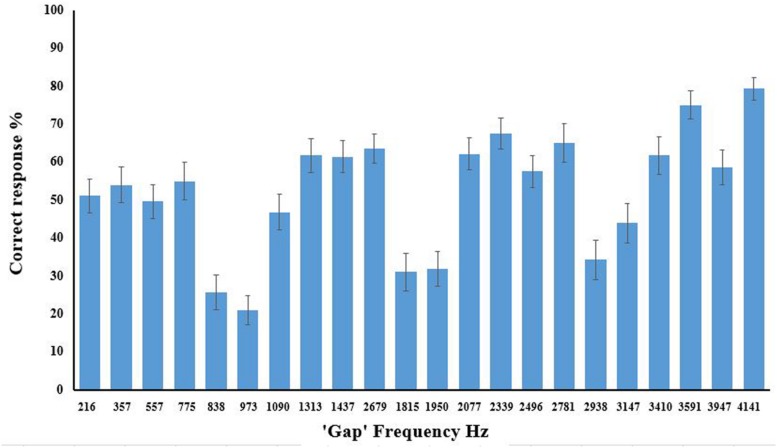
Correct response (%) for parallel line stimuli for each frequency gap prior to categorization into consonant and dissonant groups. Error bars show ±1 SEM.